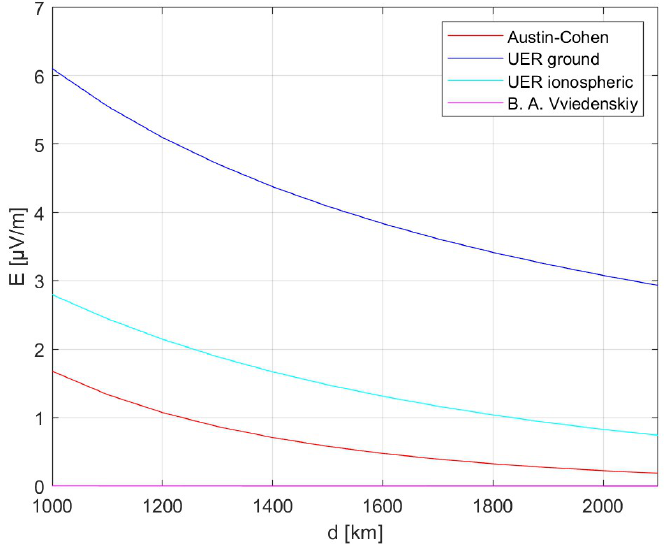
Figure 15. The selected E field strengths (RMS)—four lowest models—shown for larger ( > 1 Mm) distances for the IGLUNA 2019 LW experiment.